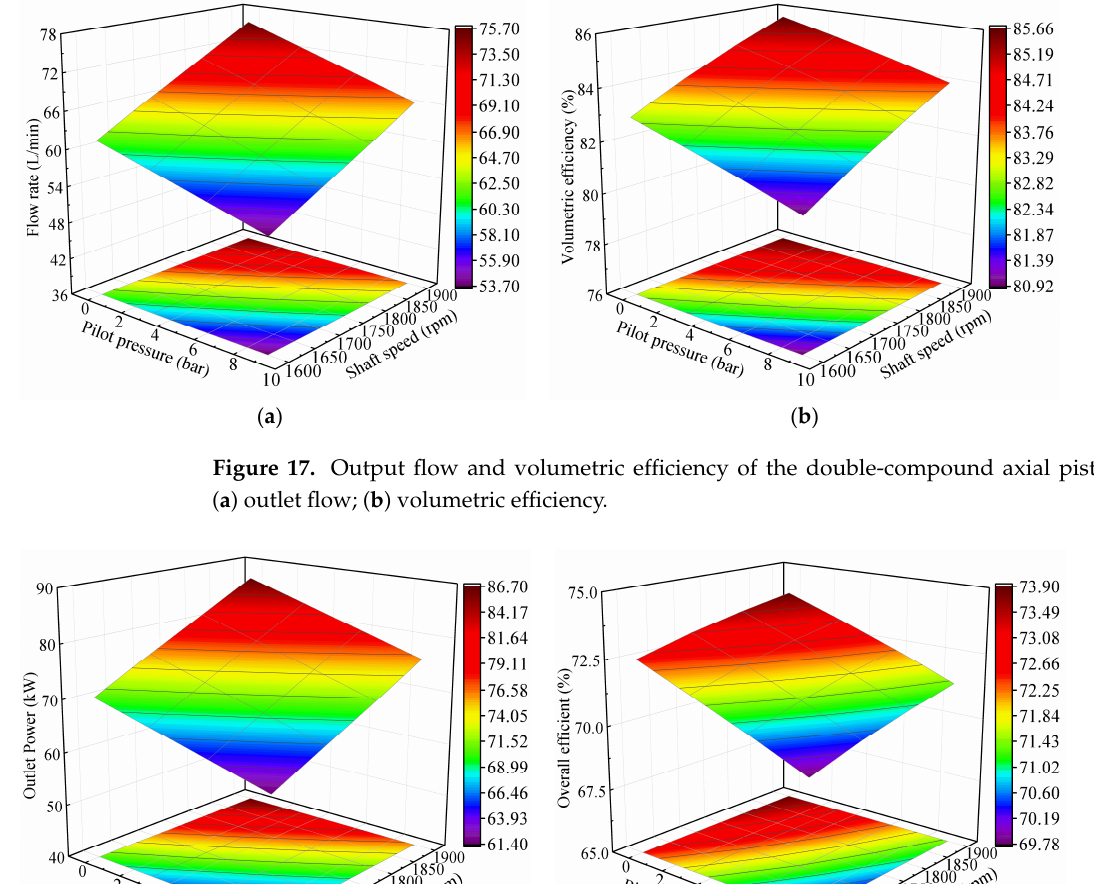
Figure 18. Output power and overall efficiency of the double-compound axial piston pump: ( a ) outlet power; ( b ) overall efficiency.